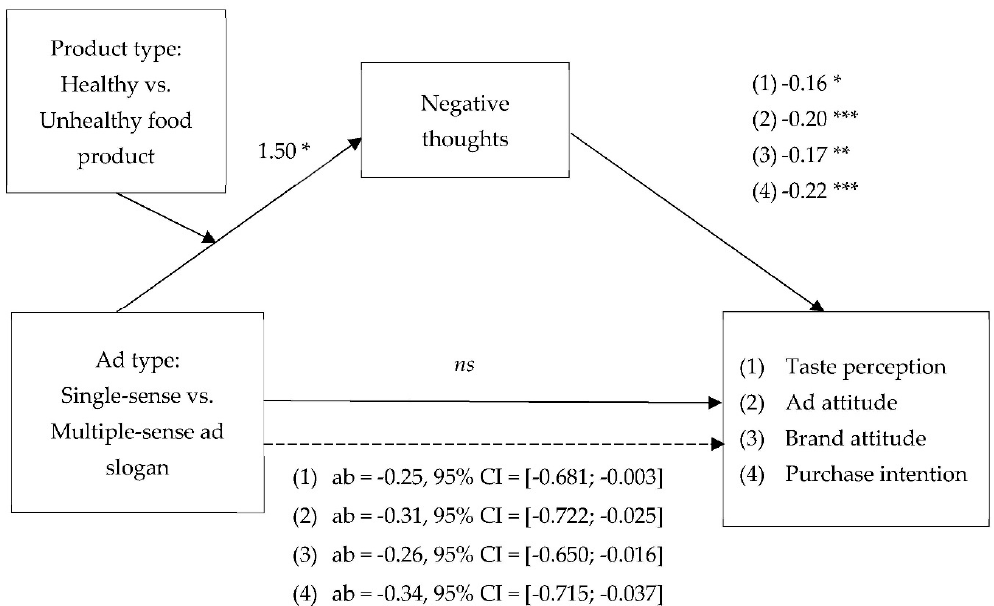
Figure 2. Results of Study 1. The effect of ad type and product type on ad effectiveness is mediated by negative thoughts. Note: Other thoughts ( t (136) = 2.46, p = 0.015); *** significant at p < 0.001; ** significant at p < 0.01; * significant at p < 0.05; ab = indirect effect; CI = Confidence Interval.